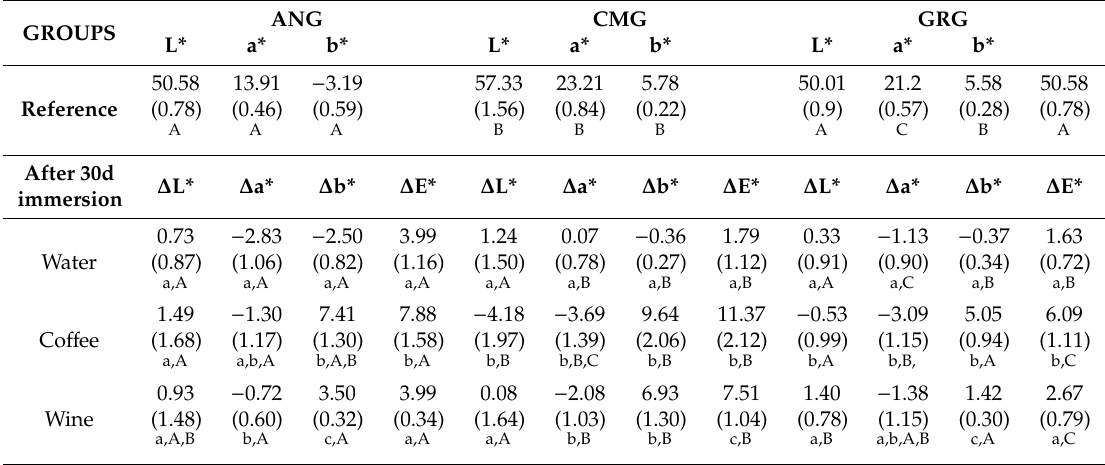
Figure 6. Photograph of the specimens before (ref) and after 30 days immersion in water, coffee and red wine. Table 4. The results of the color parameters (means and standard deviations).